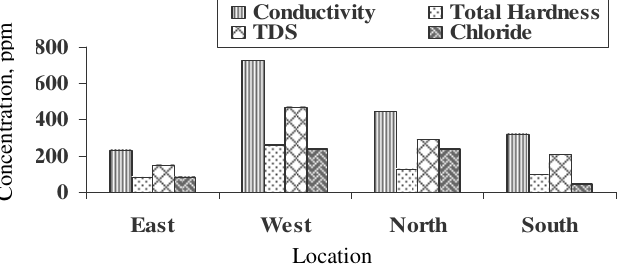
Figure 1. Variation of TDS, EC, TH and Cl - in the groundwater samples of Eloor